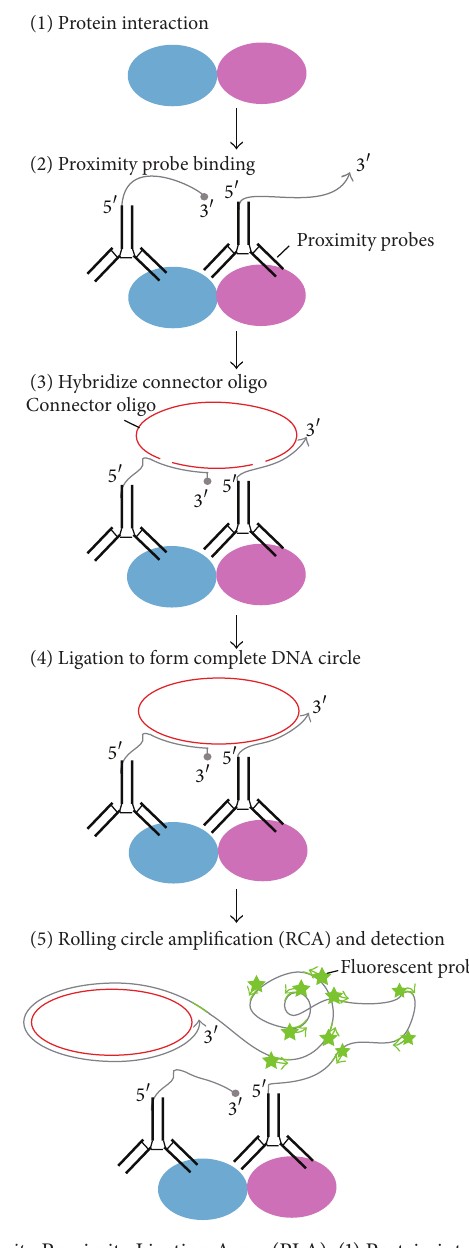
Figure 7: Schematic representation of in situ Proximity Ligation Assay (PLA). (1) Protein interaction: the complex is formed between target proteins (light blue and pink). (2) Proximity probe binding: antibodies (black) with individual proximity probes (glay) bind to each of the target protein complexes. (3) Hybridization of connector oligo-DNAs: target protein complex serves to template the hybridization of connector oligo-DNAs (red). (4) Ligation to form complete DNA circle: adjacent connector oligos that are perfectly complementary to the target template are connected by DNA ligase. (5) Rolling Circle Amplification (RCA) and detection: after ligation, the RCA is initiated by the Phi29 DNA polymerase, by turning the target molecule primed by one of the proximity probes. The RCA product is detected through the hybridization of fluorescently labeled probes (green). Arrowheads indicate 3 󸀠 ends, and roundheads means 3 󸀠 ends modified with 2 󸀠 O -methyl